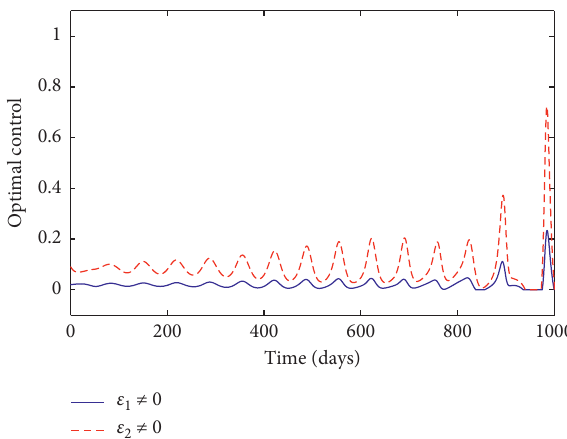
Figure 10: Optimal control strategy with ε